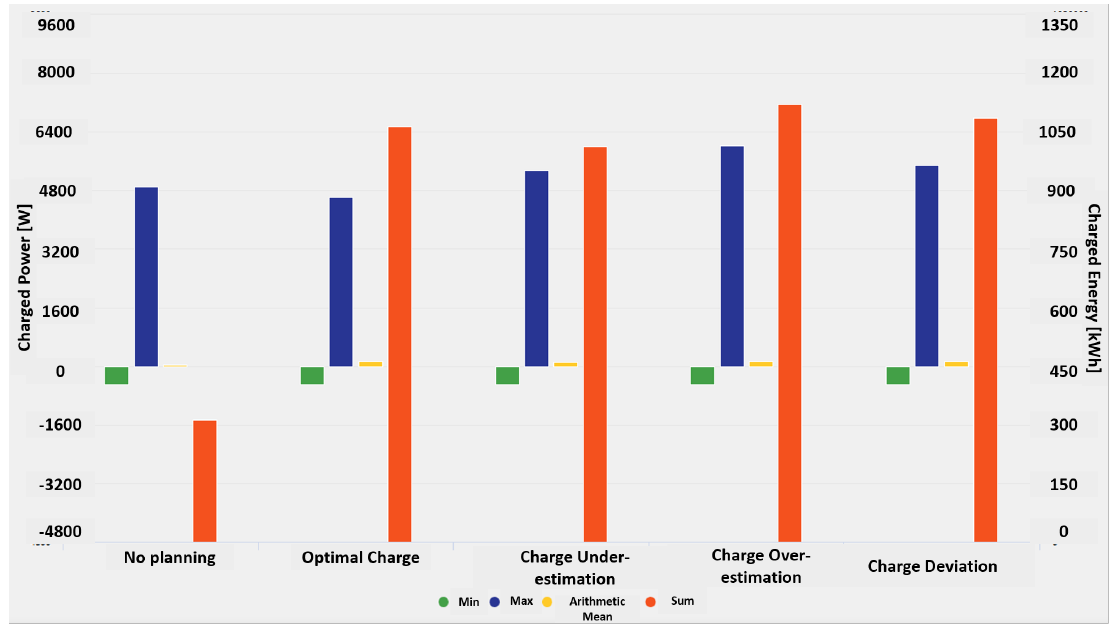
Figure 10. Differences in charging behavior for the different